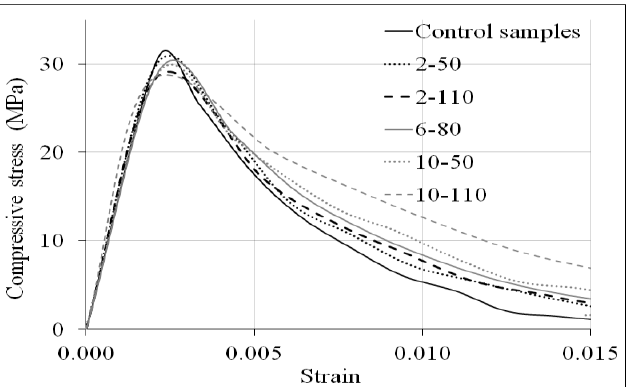
Figure 5. Compressive stress-strain curves of control samples and concrete samples with recycled PET fibres.